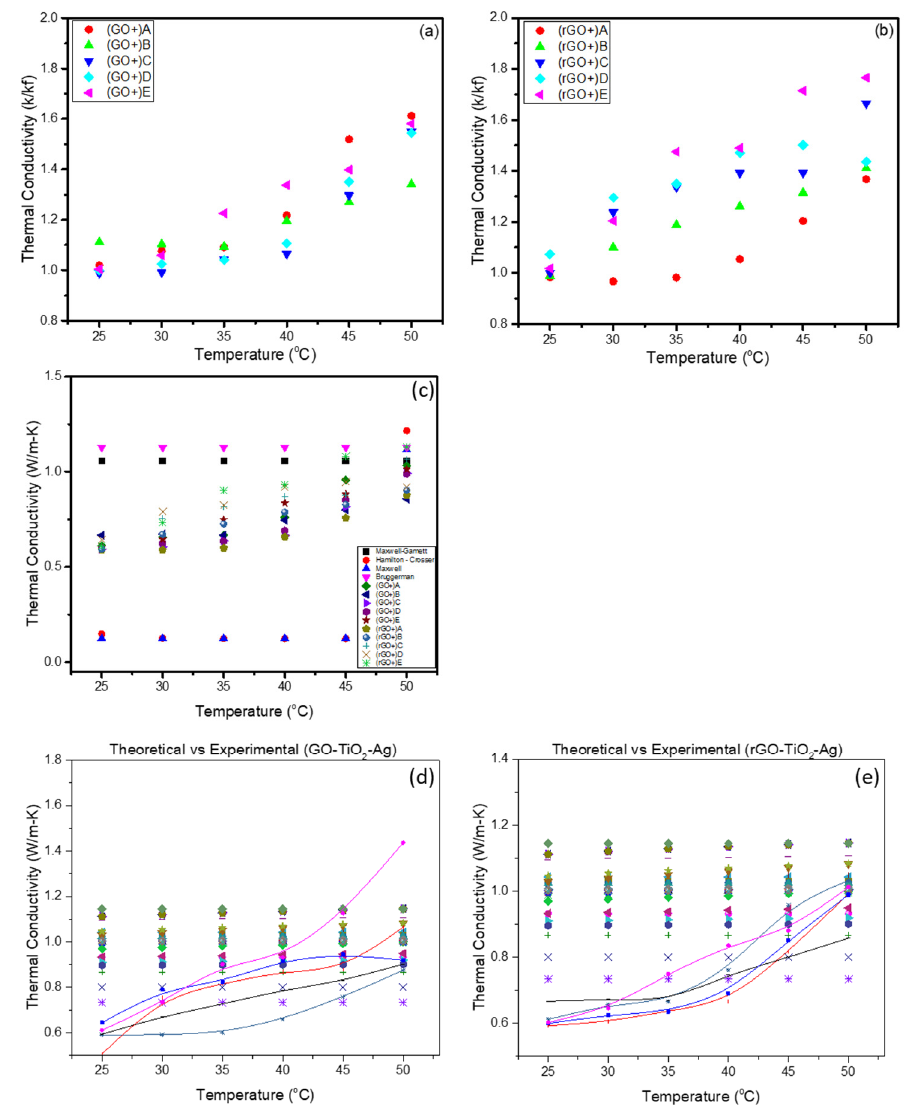
Figure 4. ( a ) Thermal conductivity of THNp GO-TiO 2 -Ag. ( b ) rGO-TiO 2 -Ag at various temperatures (where A (5 × 10 − 1 wt.%), B (5 × 10 − 2 wt.%), C (5 × 10 − 3 wt.%), D (5 × 10 − 4 wt.%), and E (5 × 10 − 5 wt.%) are serial dilutions). ( c ) Comparison of experimental values of GO-TiO 2 -Ag nanofluids with classical theoretical models. ( d , e ) Comparison of experimental values of GO-TiO 2 -Ag and rGO-TiO 2 -Ag nanofluids with the existing hybrid empirical correlations respectively. The legend of , , , , and are the data from Afrand et al. [29] hybrid nanoparticle, while , , , , and are Nabil et al. [9] data. , , , , and are Esfahani et al. [7] data, while , , , , and are Hemmat et al. [30] data . , , , , and are Hemmat et al. [31] data, also , , , , and Hemmat et al. [32] data as well as , , , , and Hemmat et al. [33]. , , , , and are Rostamian et al. [34] data. , , , , and arethe data of rGO-TiO 2 -Ag at concentration A (5 × 10 − 1 wt.%), B (5 × 10 − 2 wt.%), C (5 × 10 − 3 wt.%), D (5 × 10 − 4 wt.%), and E (5 × 10 − 5 wt.%), respectively.